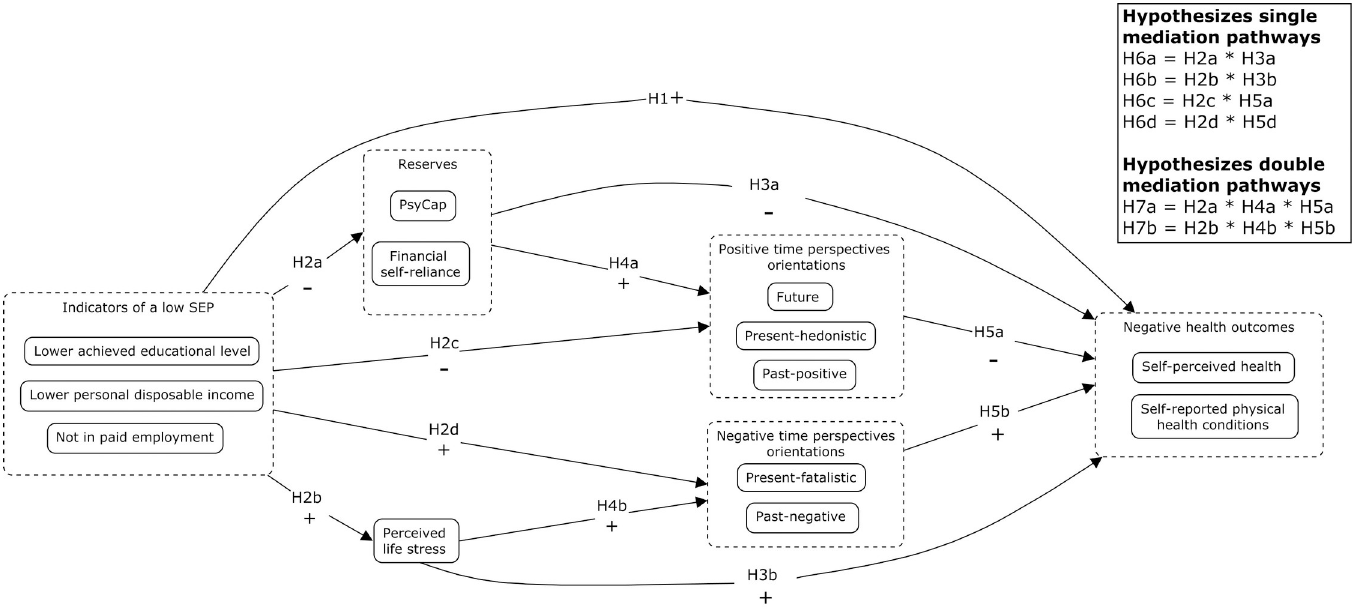
Fig 1. Model and hypotheses tested in the current